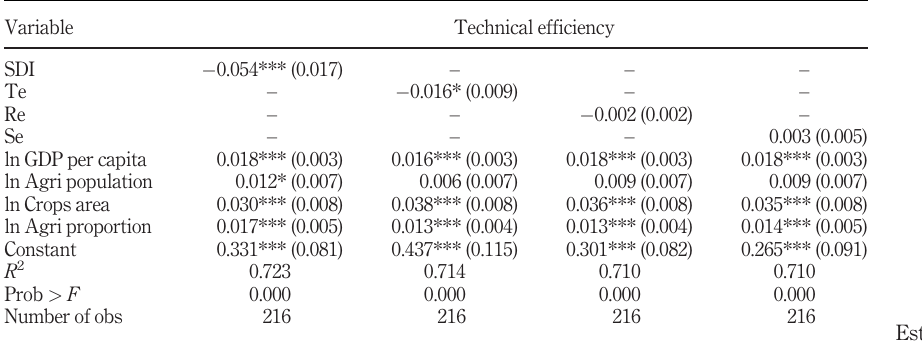
Table 5. Estimated results